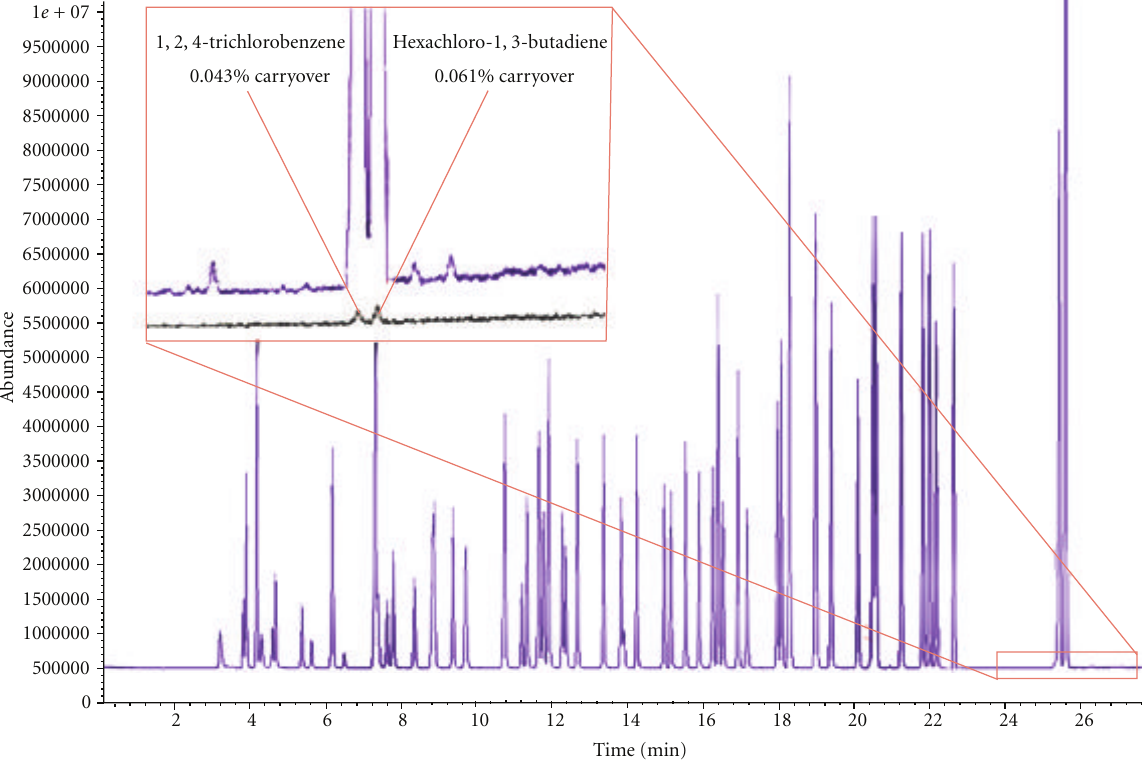
FIGURE 3: Main image: analysis of 40 mL of a 1 ppm 62-component “US EPA TO-15 air toxics” standard (i.e., a heavily overloaded sample) using a CIA -Advantage system, (Markes International Ltd). Inset: Expansion of the peaks for 1,2,4-trichlorobenzene and hexachloro-1,3-butadiene, showing subsequent analysis of a 500 mL nitrogen blank demonstrating very low carryover even under extreme conditions and for these late-eluting components (method conditions are shown in Table 2).